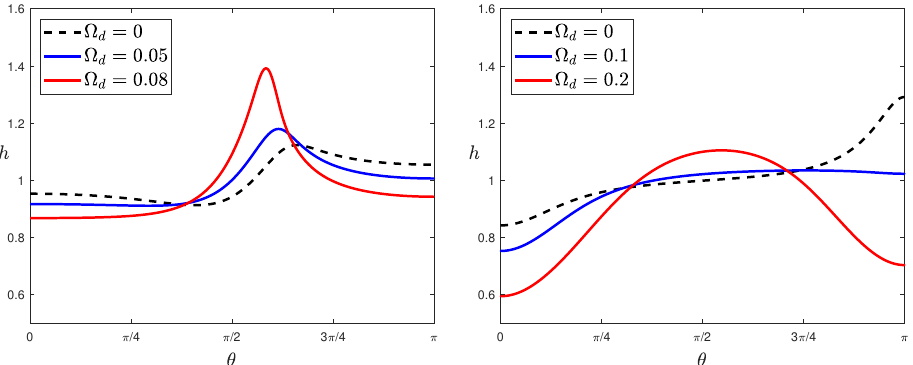
Figure 6. Variations in the steady thickness profiles for Bo = 0.0057, where the angular velocity varies on the spheroid. ( left ) Oblate spheroid γ = 0.5, angular velocity Ω d = 0,0.05,0.08; ( right ) Prolate spheroid γ = 2, angular velocity Ω d =